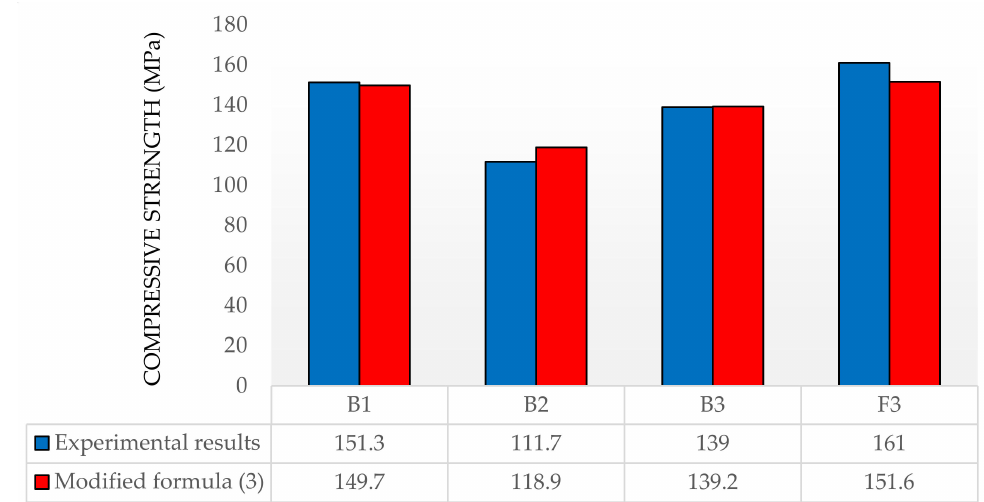
Figure 1. Experimental and designed compressive strength of concrete.